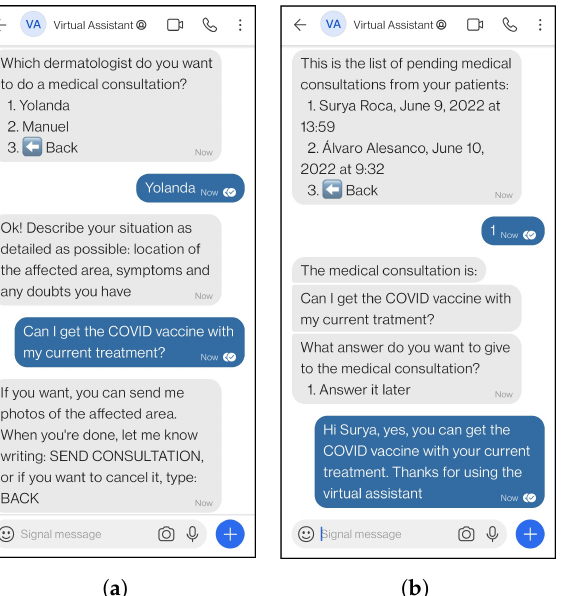
Figure 1. Example of real interactions with the virtual assistant using Medical consultation functional- ity. ( a ) Patient interaction. ( b ) Healthcare professional interaction.